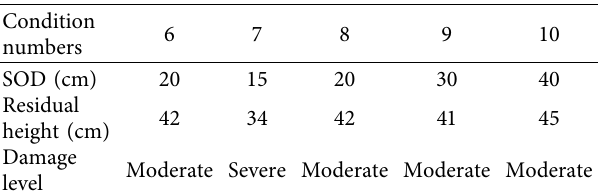
Table 3: Residual height of the concrete pile under JPC